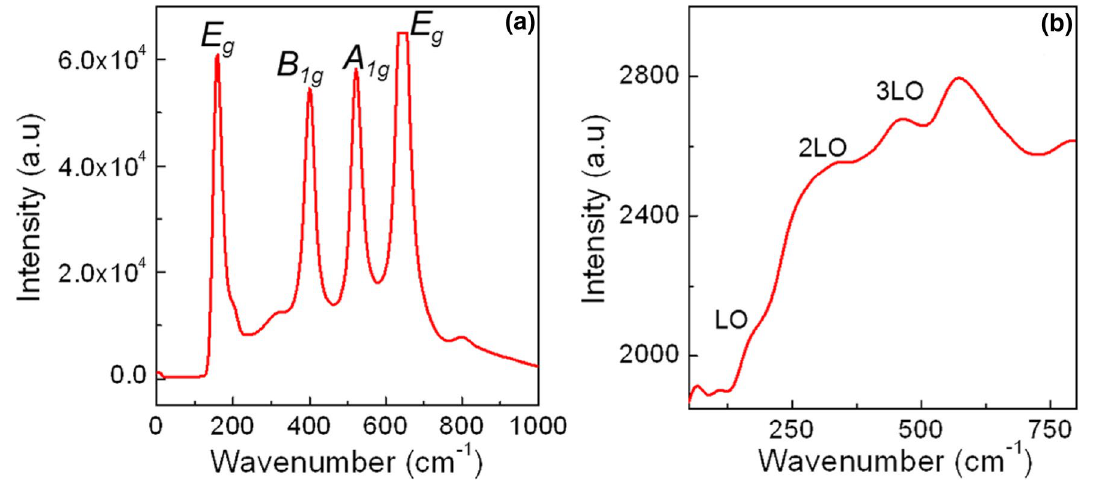
Fig. 3 SEM images show a cross-sectional view of heterogeneous CdTe–TiO 2 film on FTO coated glass substrate, b surface morphol- ogy of the TiO 2 with no CdTe layer on the surface c and d surface